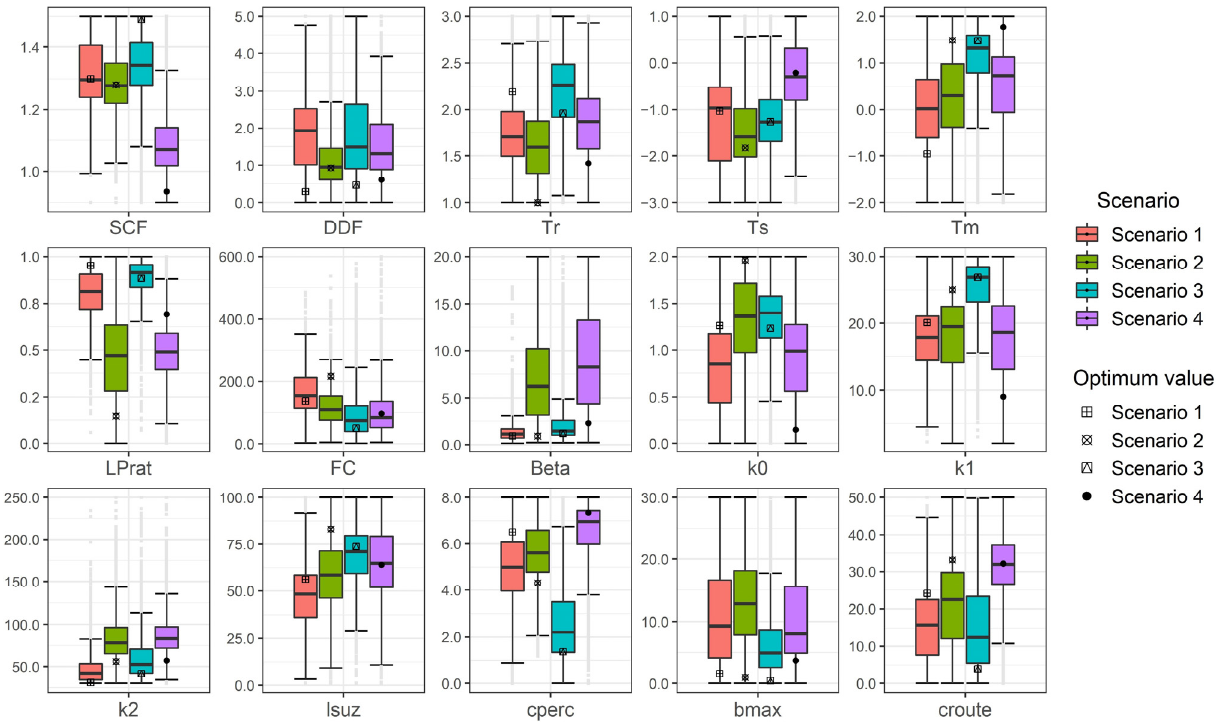
Figure 4. Box-and-whisker plots of behavioral parameter sets (KGE > 0.3) versus parameter values (2572 sets). The points indicate the optimum parameter value found through the optimization where the lower and upper edges of the box represent the 25th and 75th percentile values, respectively, while the “whiskers” represent the minimum and maximum values.